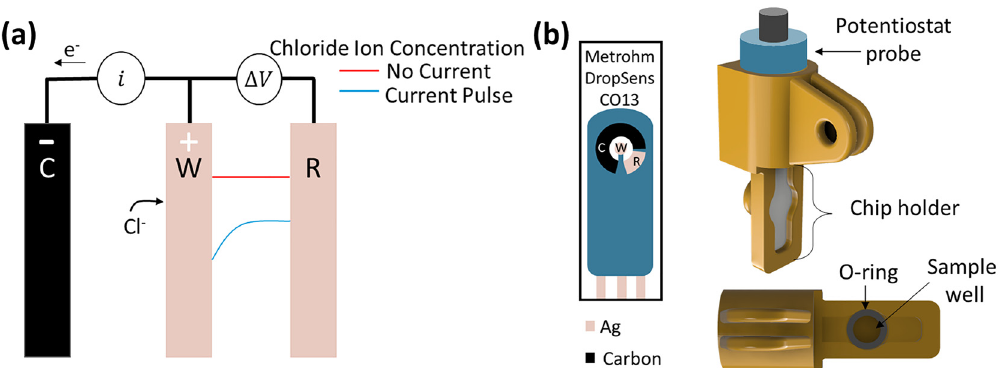
Figure 1. ( a ) Schematic of chronopotentiometric method. The local depletion creates a chloride ion concentration gradient, shown by the blue curve, between the working and reference electrodes. ( b ) Schematic of DropSens C013 screen-printed electrodes and chip holder. The working electrode (W) and reference electrode (R) are silver, while the counter electrode (C) is made of